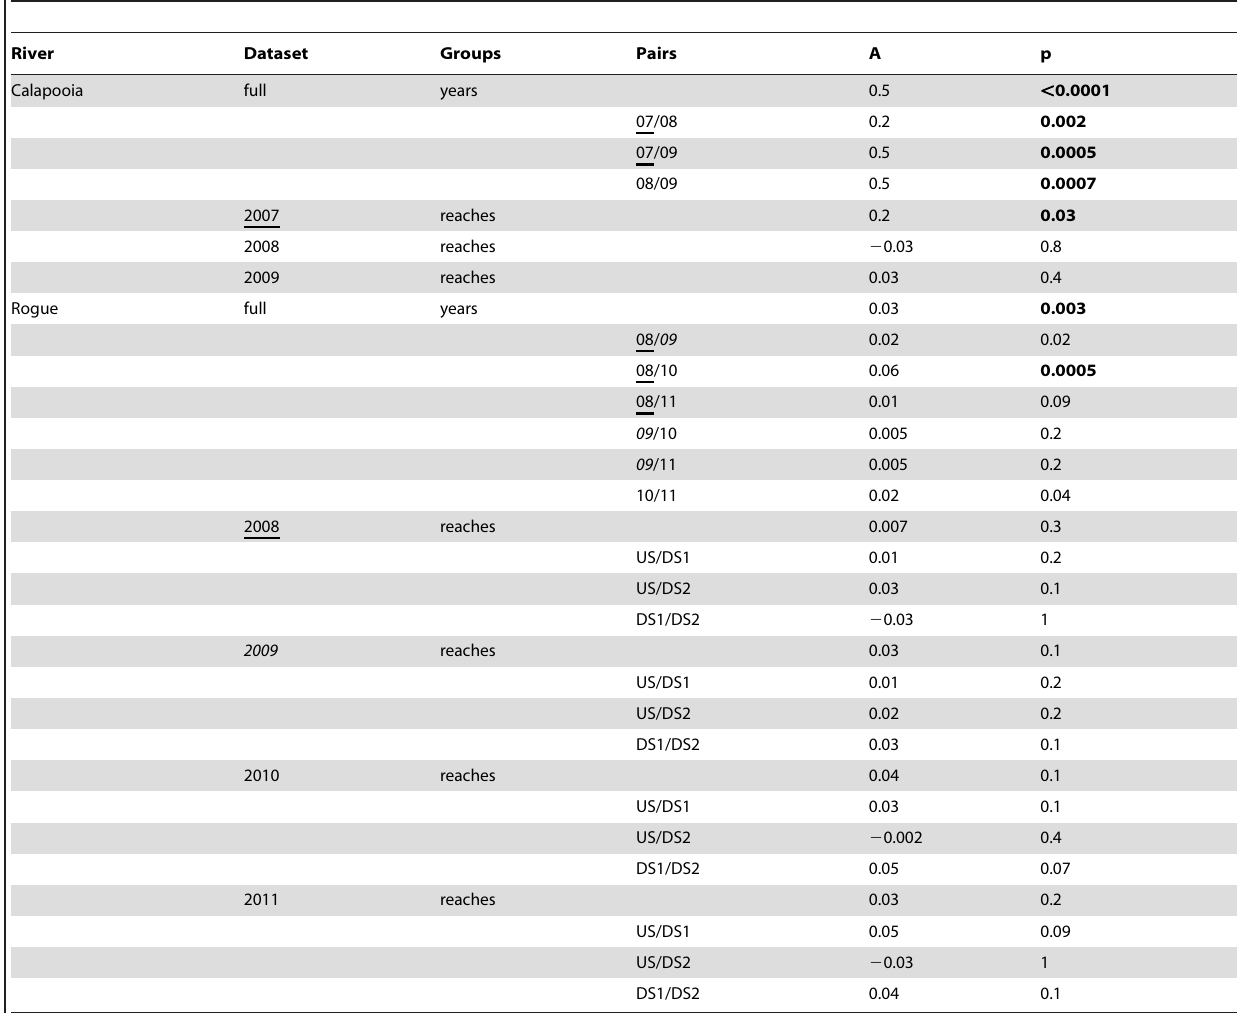
Table 4. Results of MRPP analysis for differences among functionally-defined assemblages in both rivers, according to a suite of 20 life-history, mobility, morphological, and ecological